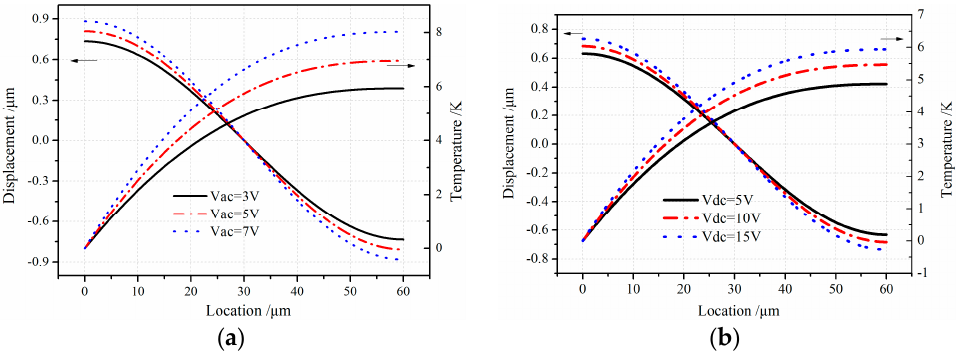
Figure 4. Influence of electrostatic parameters on the field quantities along the axial direction of movable comb finger; ( a ) u , θ versus Vac; ( b ) u , θ versus Vdc.